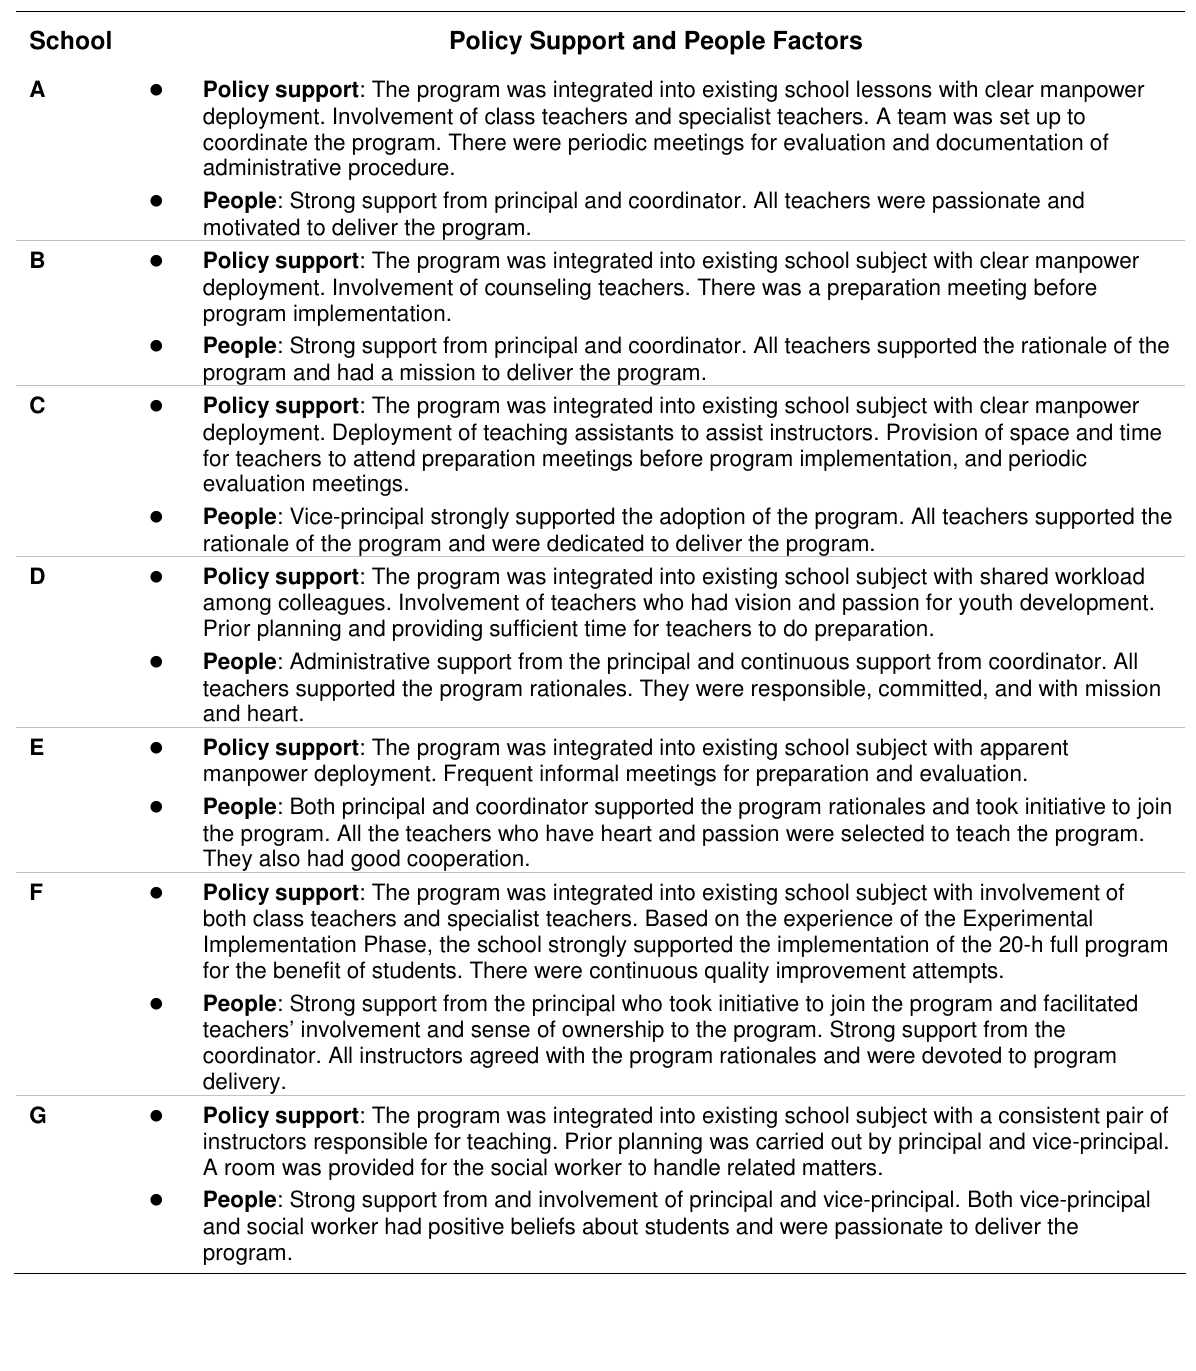
Policy Support and People Factors in Each School